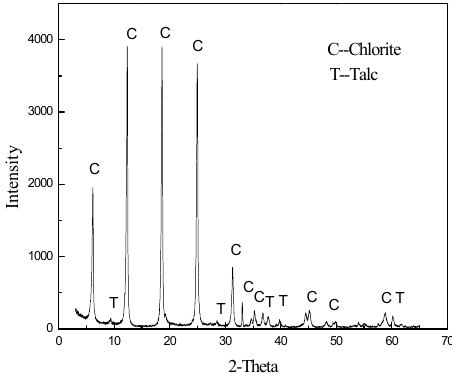
Figure 2. X-ray diffraction (XRD) pattern of the chlorite sample.